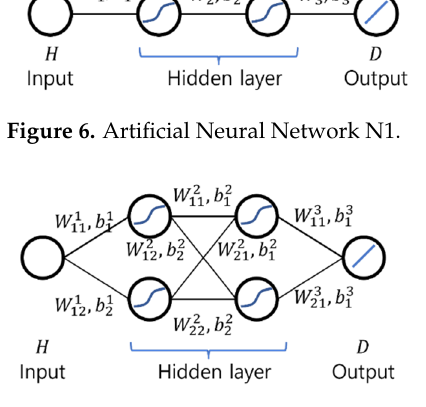
Figure 7. Artificial Neural Network N2. Usually, an ANN is trained through the iterative forward and backward propaga- tion. Forward propagation is a process in which ANN outputs the predicted value through operations in the hidden layer while backward propagation is a process that ad- justs the weight and bias for minimizing difference between the known target value and predicted value. There are many algorithms for backward propagation such as gradient descent, resilient propagation, and so on [25]. In order to train an ANN by the forward-backward propagation, existing known pairs of input and output data are required. However, the pairs of the input and output data do not exist in this study, hence the forward–backward propagation could not be